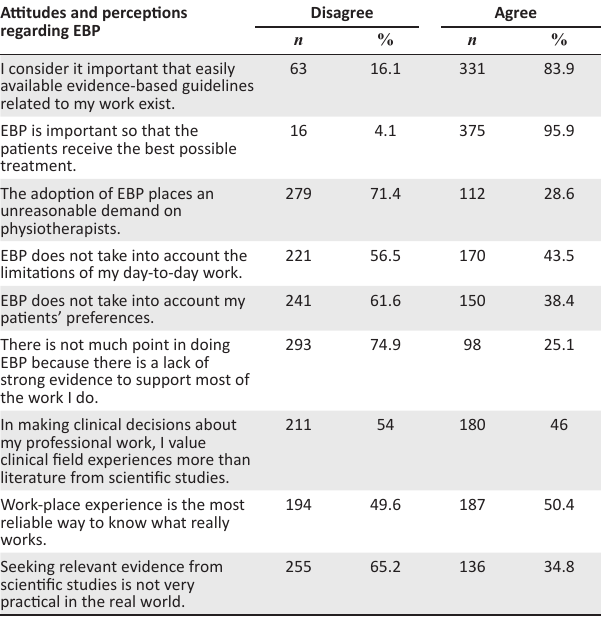
TABLE 2: Attitudes and perceptions regarding evidence-based practice (EBP) ( n = 391). Attitudes and perceptions regarding EBP